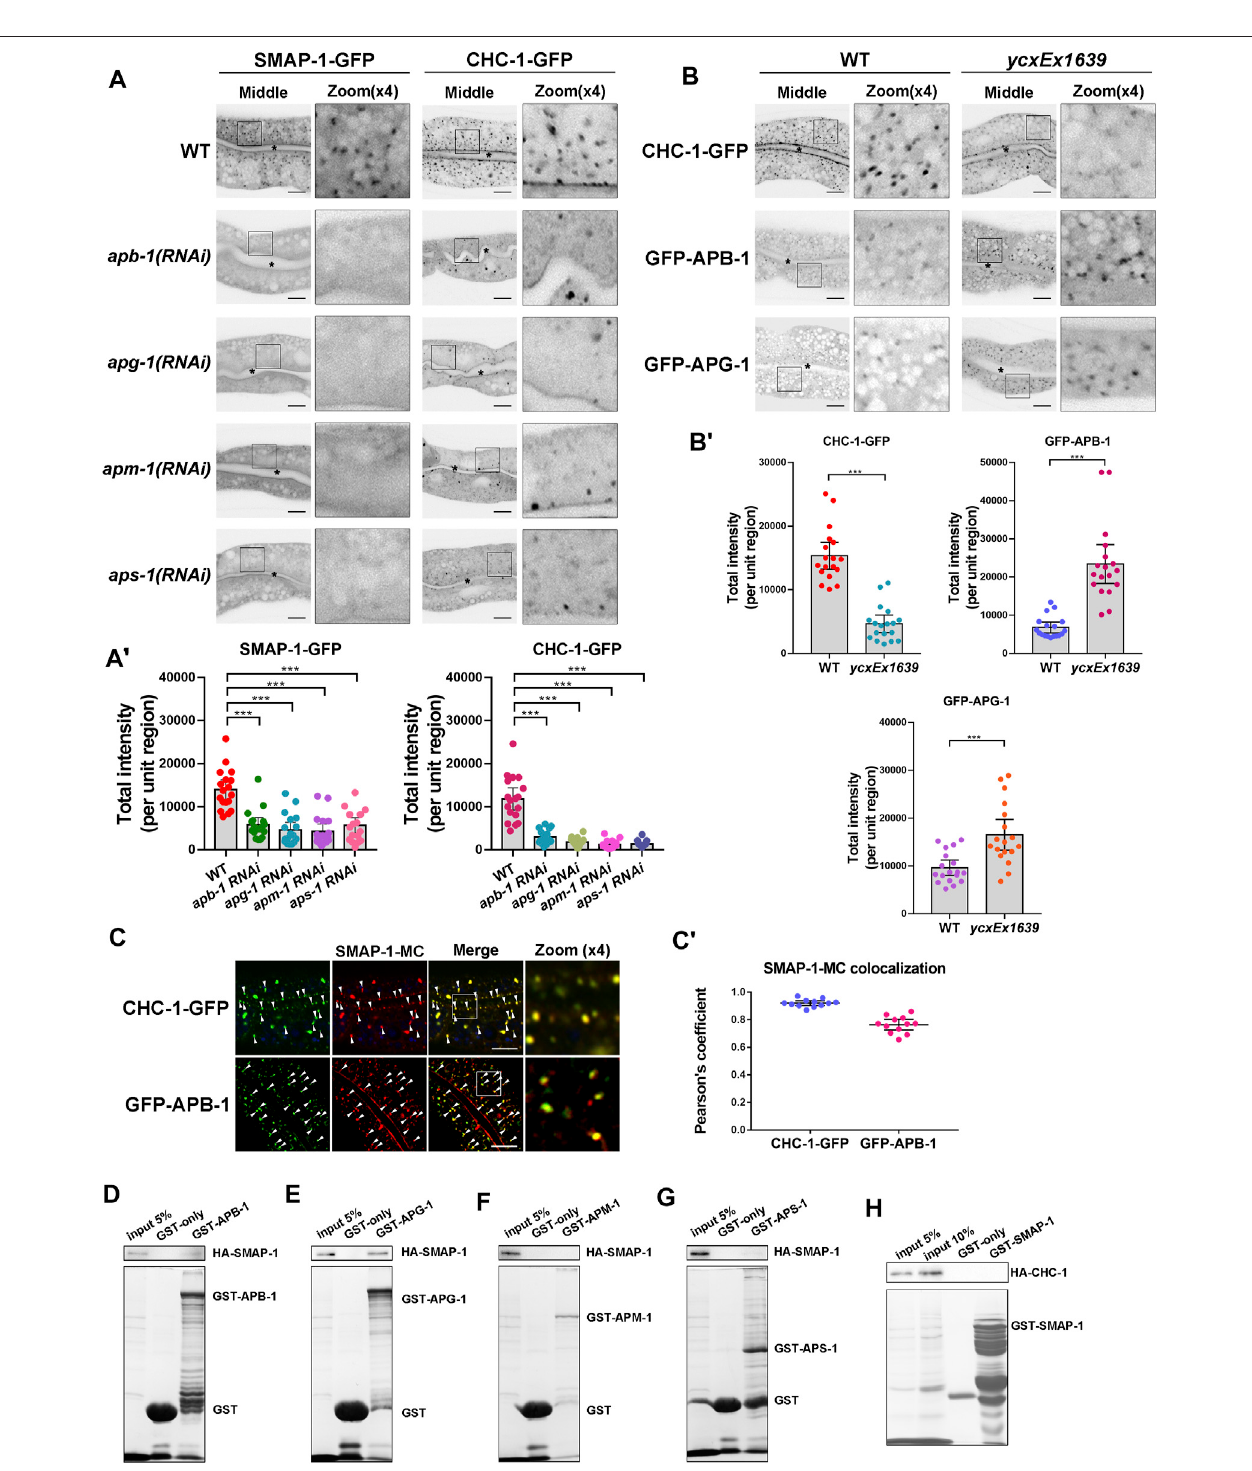
FIGURE 3 | The localization of SMAP-1 in the trans-Golgi network requires AP-1. (A-A 9 ) In the middle focal plane, SMAP-1-GFP-labeled structures were reduced upon loss of AP-1 subunits. Also, the punctate structures labeled by CHC-1 (clathrin heavy chain) were decreased in the absence of AP-1 subunits. Error bars are 95% CIs (n (cid:1) 18 each). Asterisks designate the signi fi cant differences in a one-way ANOVA followed by a post-hoc test (Dunn ’ s Multiple Comparison Test) for multiple comparisons (*** p < 0.001). (B-B 9 ) Loss of SMAP-1 led to the accumulation of GFP-APG-1 and GFP-APB-1 on the punctate structures. In contrast, CHC-1- positive punctate structures were reduced in SMAP-1-de fi cient cells. Error bars are 95% CIs (n (cid:1) 18 each). Asterisks designate the signi fi cant differences in the Mann- Whitney test (*** p < 0.001). (C-C 9 ) SMAP-1-mCherry colocalized well with CHC-1 and APB-1. Arrowheads designate structures co-labeled by GFP and mCherry. Pearson ’ scorrelationcoef fi cients arecalculated,error bars are95%CIs (n (cid:1) 12animals). (D – H) Western blotshowingGSTpull-down with invitro translatedHA-tagged proteins. GST-APG-1 exhibited interactions with HA-SMAP-1. Scale bars, 10 μ m.